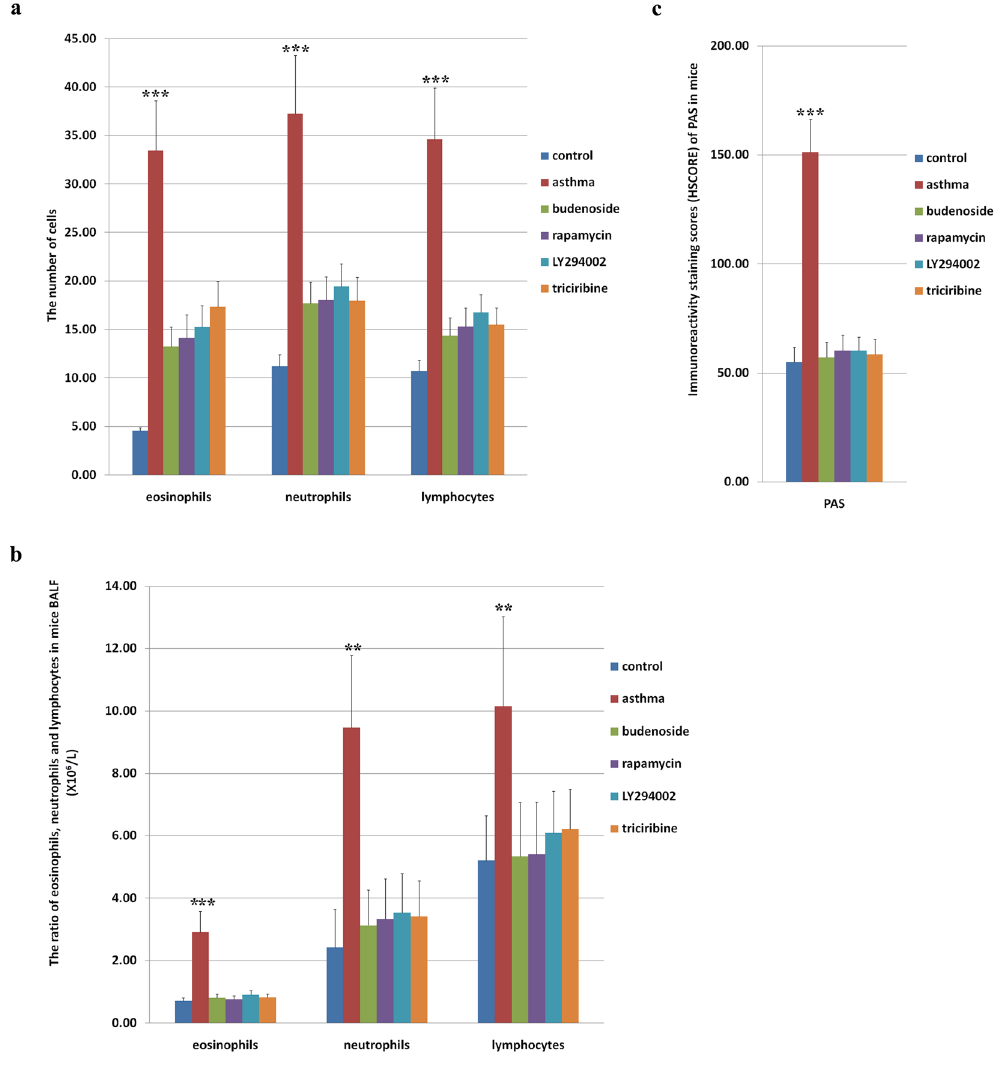
Figure 4. Inflammatory cells in mouse lung tissues and bronchoalveolar lavage fluid (BALF) after treatment with mTOR inhibitors. ( a ) The average number of inflammatory cells, namely eosinophils, neutrophils, and lymphocytes, determined by H&E staining, in the lung tissue from mice in the control group, the OVA-induced asthma group, and the OVA-induced asthmatic group that were treated with budenoside, rapamycin, LY294002, or triciribine. The asthmatic mice demonstrated significantly higher levels of inflammatory cells than in the control, budenoside treatment, and m-TOR pathway inhibitor treatment groups. ( b ) Ratio of inflammatory cells (eosinophils, neutrophils, and lymphocytes) in mouse BALF detected by flow cytometry in mice from the control group and the asthma group, and the asthmatic mice that were treated with budenoside, rapamycin, LY294002, or triciribine. The asthmatic mice demonstrated significantly higher levels of inflammatory cells than in the control, budenoside treatment, and m-TOR pathway inhibitor treatment groups. ( c ) Immunoreactivity staining score (HSCORE) of PAS-positive cells in lung tissue from mice in the control group, the OVA-induced asthma group, and the OVA-induced asthmatic group that were treated with budenoside, rapamycin, LY294002, or triciribine. The asthmatic mice demonstrated significantly higher levels of PAS-positive cells than in the control, budenoside treatment, and m-TOR pathway inhibitor treatment groups. All data was presented as the mean ± SD. * p < 0.05, ** p < 0.01, *** p <